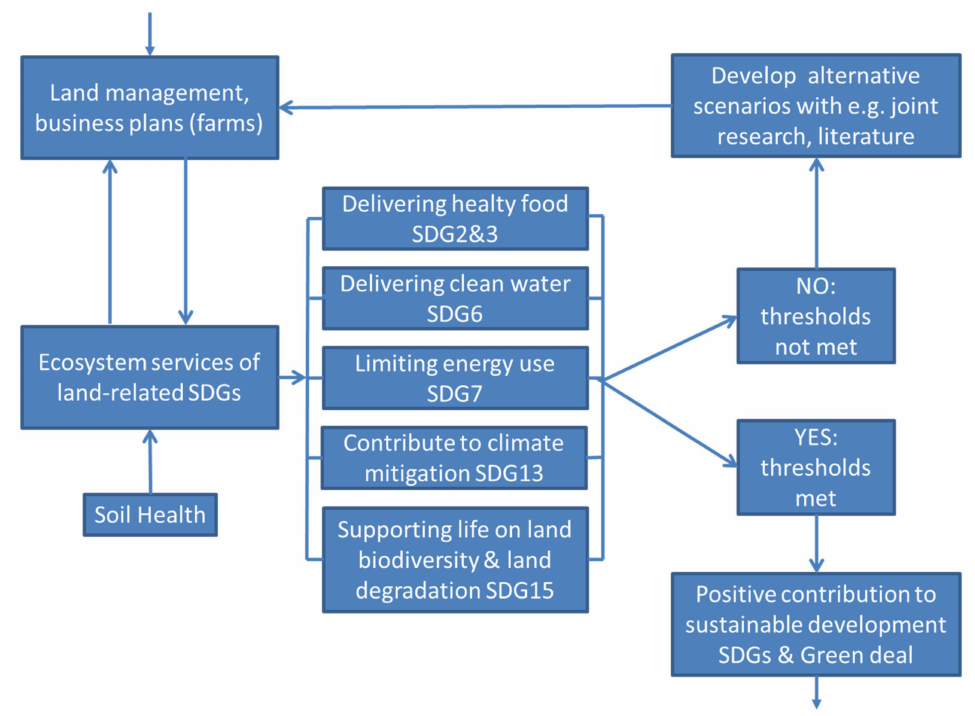
Figure 1. Flow chart demonstrating the procedure to test whether ecosystem services, contributing to achieving SDGs and the goals of the Green Deal, meet regional